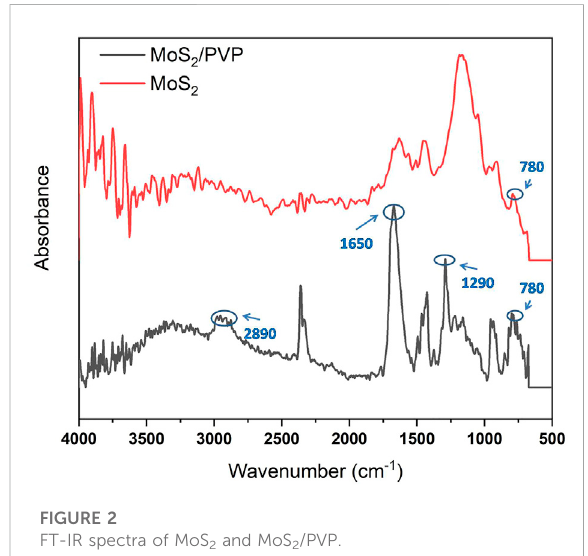
FIGURE 2 FT-IR spectra of MoS 2 and MoS 2